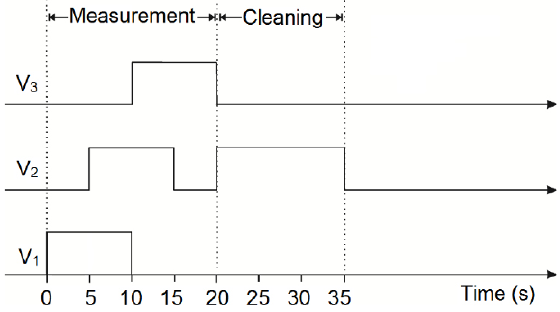
Figure 2. Schematic diagram of the measurement and cleaning steps.